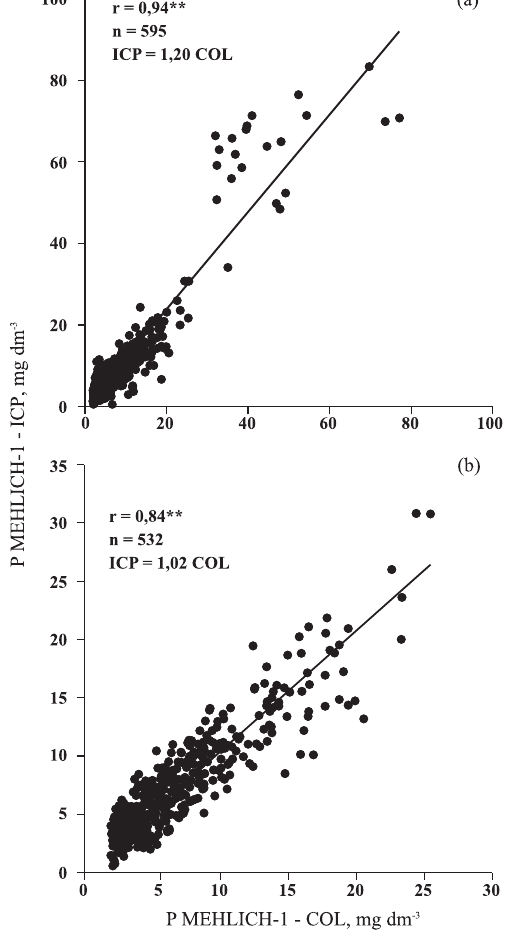
Figura 1. Relações entre os teores de P extraído pela solução de Mehlich-1, determinado por COL e por ICP: (a) em todos os solos; (b) em solos com p < 30 mg dm -3